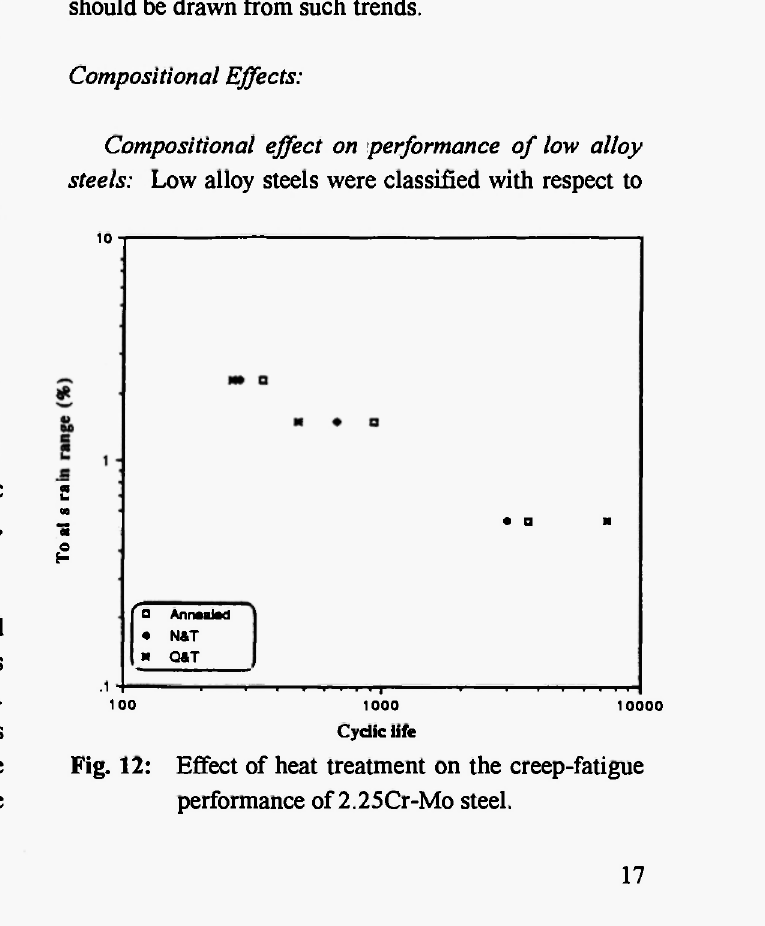
Effect of heat treatment on the creep-fatigue performance of 2.25Cr-Mo